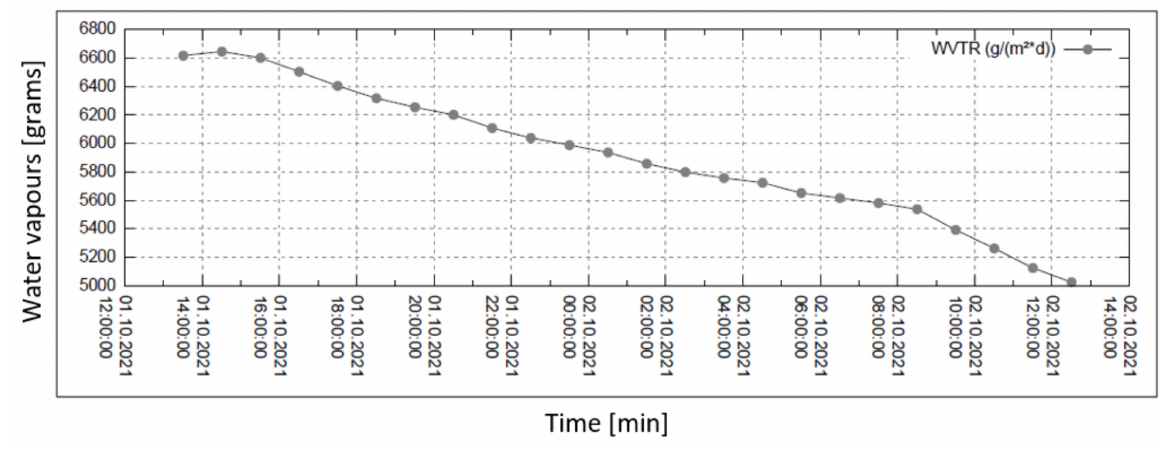
Figure 6. Permeability of water vapour over 24 h with 20% external humidity.